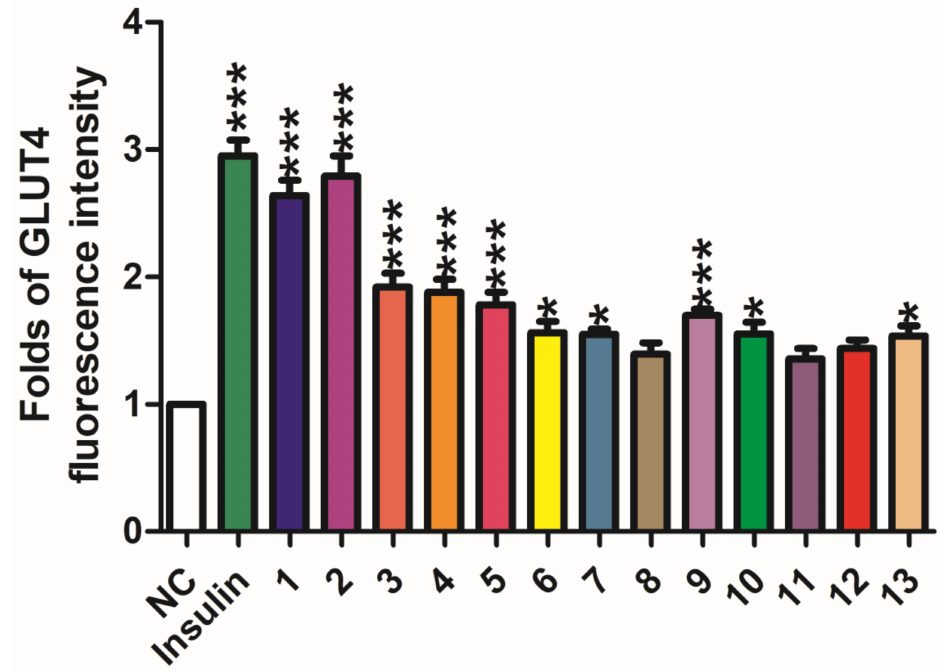
Figure 5. Effects of compounds 1 – 6 on stimulating GLUT4 translocation in L6 cells. (* p < 0.05, *** p < 0.001, compared with non-treated